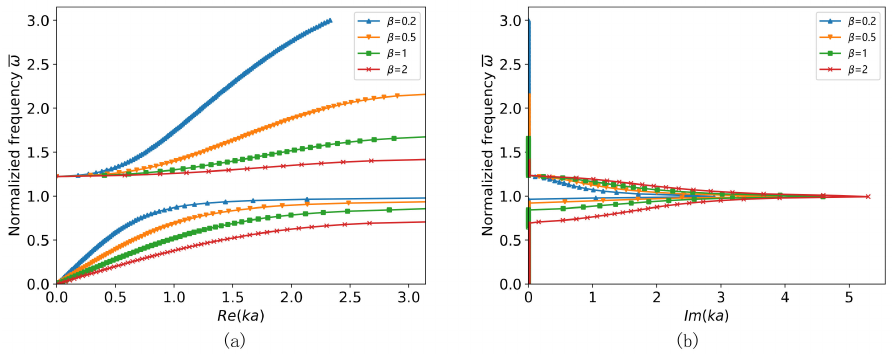
Figure 7. Dispersion relation for the linear EMs with α = 0.5 and different β .